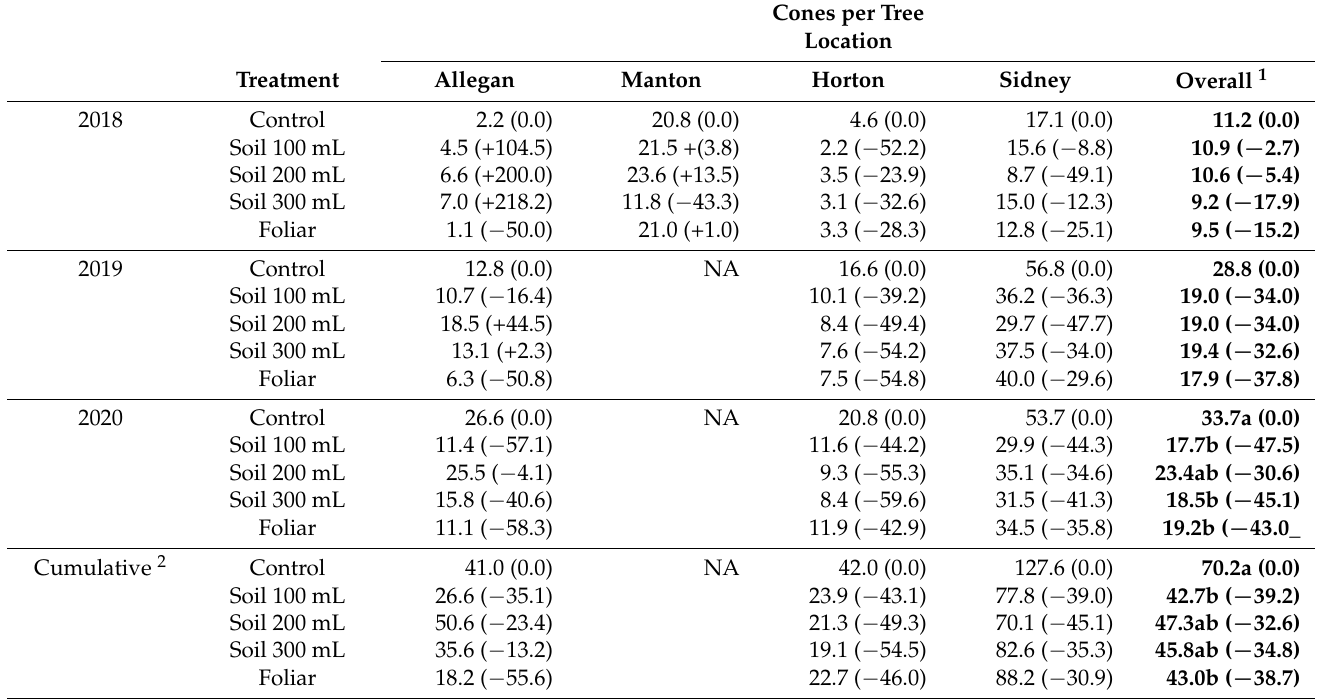
Table 2. Mean cone density of Fraser fir trees treated with soil injected or foliar applied paclobutrazol. Soil treatments were applied in 2017. Foliar treatments were applied annually 2017–2019. Figures in parentheses indicate change in means relative to untreated